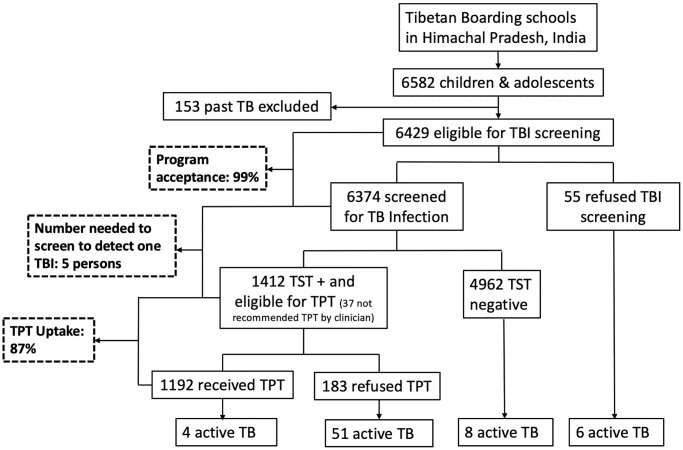
Care cascade for TBI screening and TPT in children and adolescents from 2017 through 2019.TB, tuberculosis; TBI, tuberculosis infection; TPT, tuberculosis preventive treatment; TST, tuberculin skin testing.